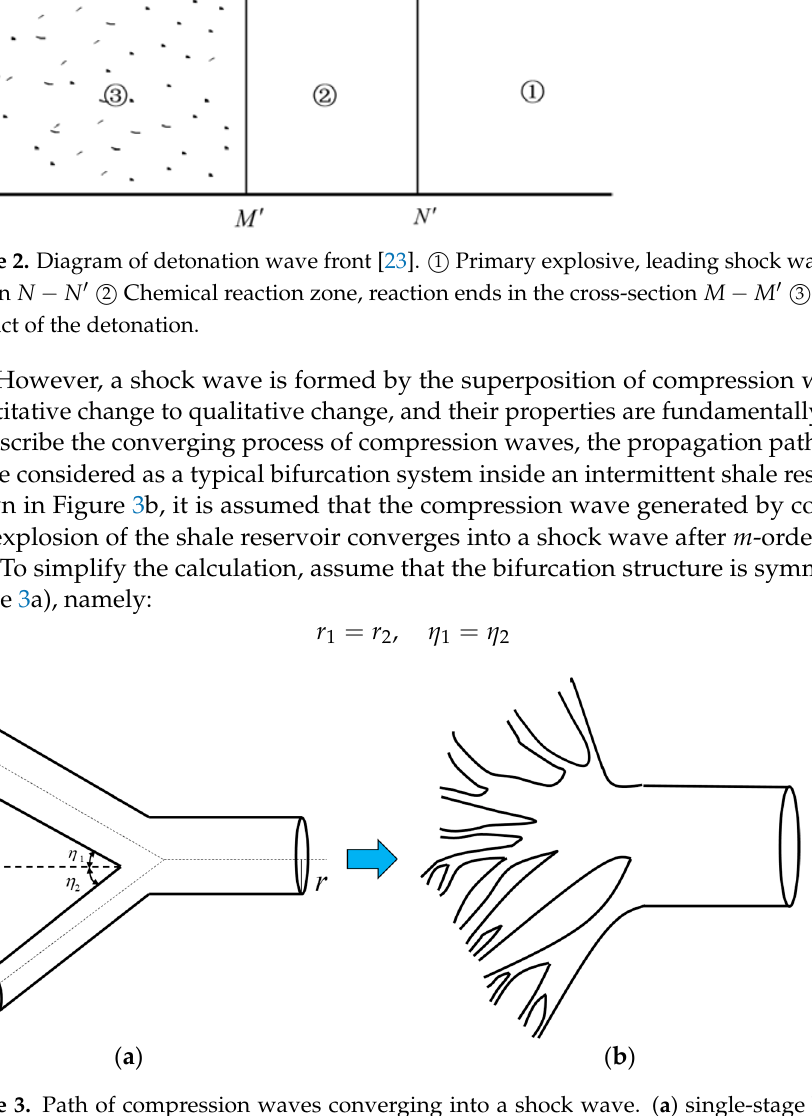
Figure 2. Diagram of detonation wave front [23]. ① Primary explosive, leading shock wave of cross- section N